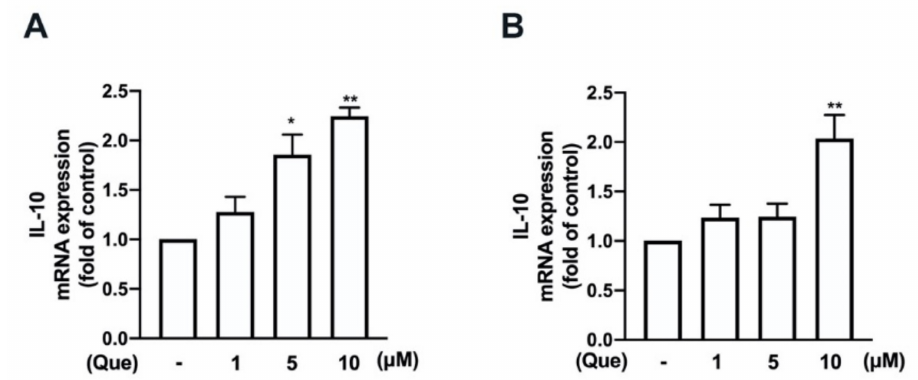
Figure 8. Effects of quercetin on the expression levels of anti-inflammation gene IL-10 in macrophages and microglial cells. RAW264.7 ( A ) and IMG ( B ) cells were stimulated with various concentrations of quercetin (1, 5, or 10 µ M) for 6 h. The mRNA levels IL-10 were analyzed by real-time PCR and normalized to β -actin. Each bar represents the mean ± SEM ( n = 3). Note: ** p < 0.01, * p < 0.05 compared with the control group.